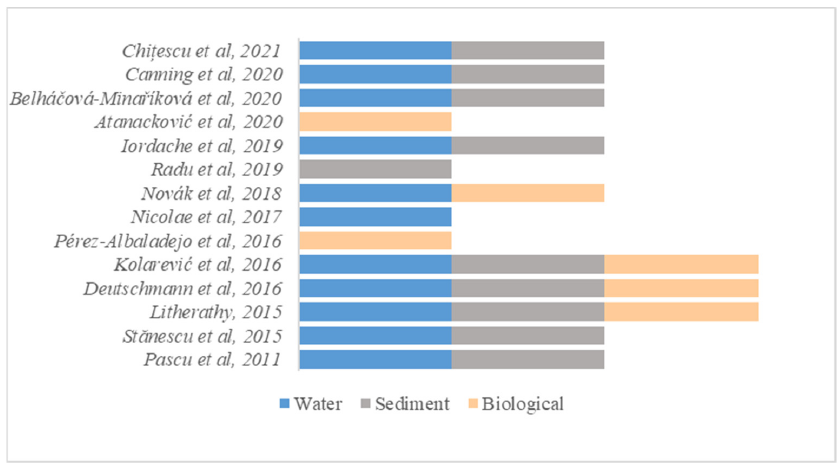
Figure 5. The main samples used in hydrocarbon pollution analyses of Danube